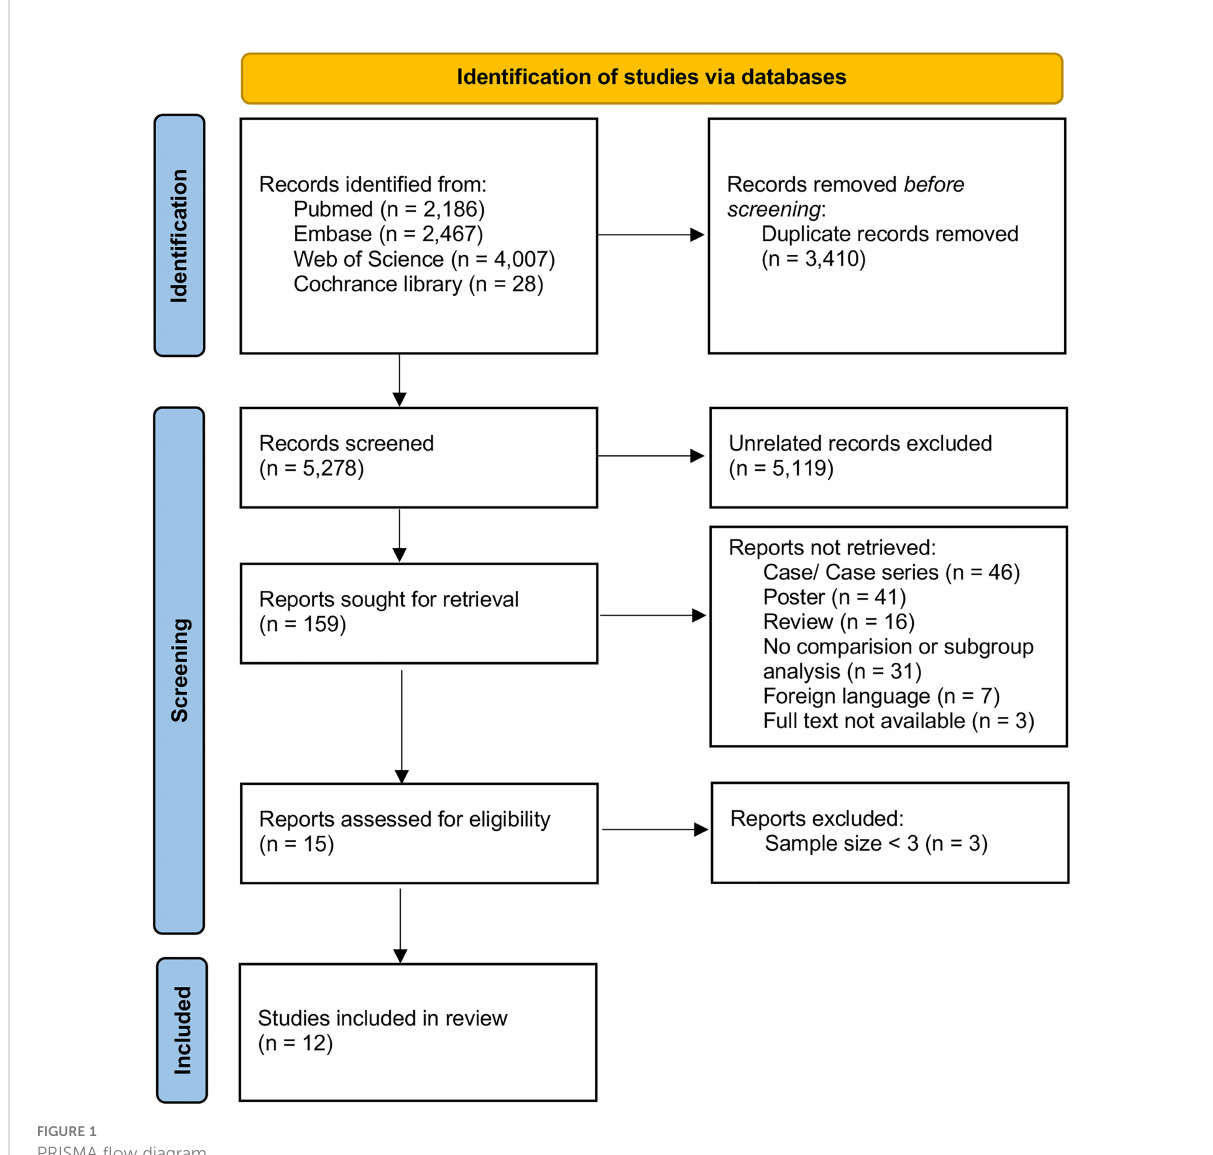
FIGURE 1 PRISMA fl ow